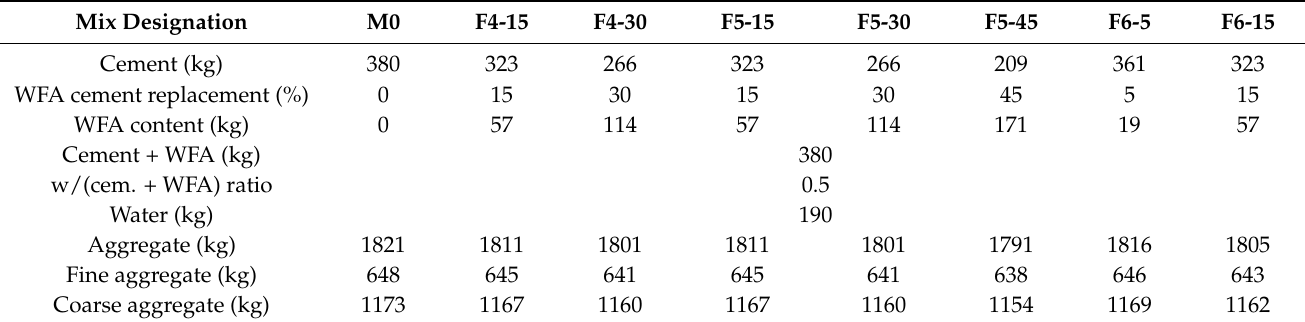
Table 2. Concrete mix composition (quantities per 1 m 3 of